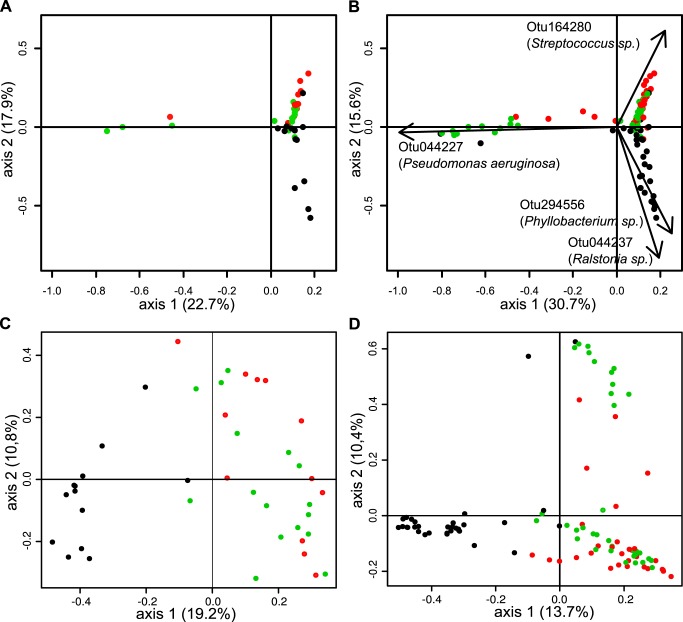
Spatial analysis of the airways microbiome.Nasal swabs are represented by black dots, throat swabs by red dots, sputum samples by green dots. (A) Principal Component Analysis of samples obtained from clinically stable children with CF. In panel (B) samples from patients during exacerbation were added. Pearson correlations were performed to highlight which OTUs were responsible for the divergence among the samples. Correlation was considered significant when the coefficient of correlation was higher than 0.6 and p-value < 0.01. (C) Principal Coordinates Analysis was performed on samples obtained from clinically stable CF patients or (D) on all available samples from CF patients irrespective of the clinical status.